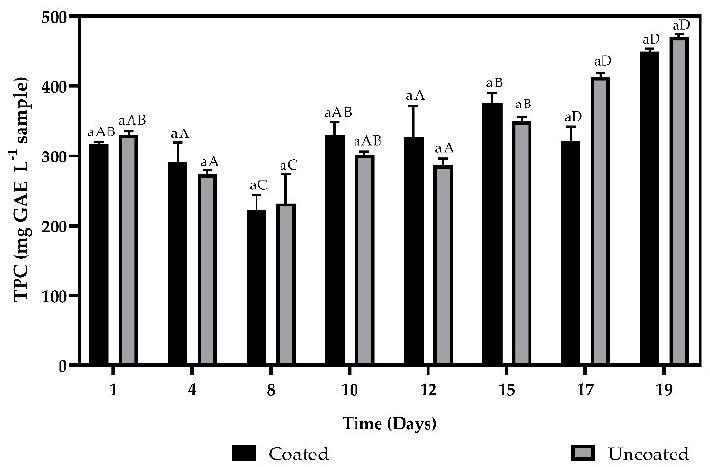
Figure 4. Total phenolic content of coated and uncoated fruits. The averages with a common letter are not significantly different according to the Tukey test ( p ≥ 0.05). Uppercase letters differences between days and lowercase letters differences between material coated and uncoated fruits.